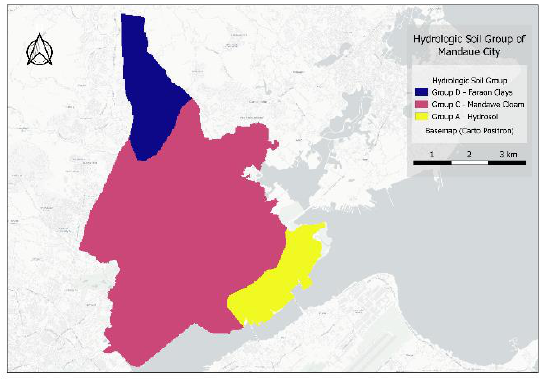
Figure 8. Soil group map of Mandaue City,